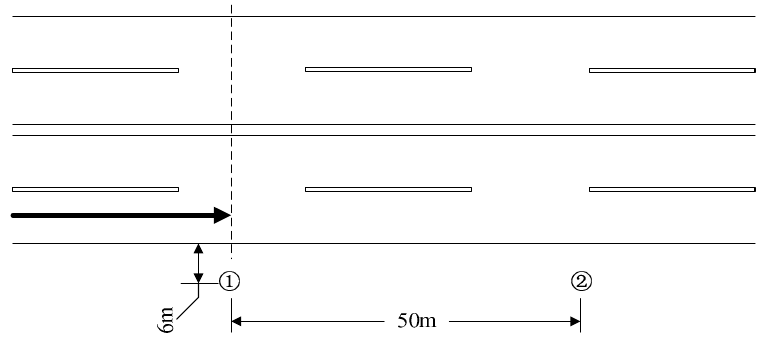
Figure 1. Locations of the Measurement Spots.